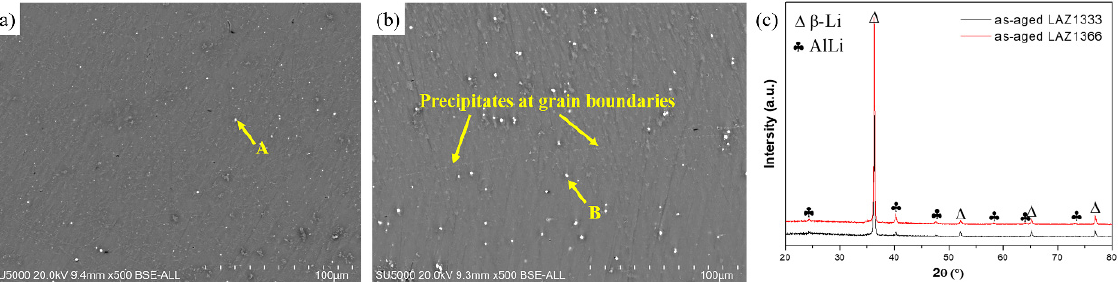
Figure 9. The microstructure of as-aged LAZ13 xy ( x = 3, 6 wt%, y = 3, 6 wt%) alloys: SEM images of ( a ) LAZ1333 and ( b ) LAZ1366, ( c ) XRD pattern. Table 2. The EDS results of the second phases marked by the yellow arrows and letters in Figure 9a,b. Chemical Compositions (at%) Positions Mg Al